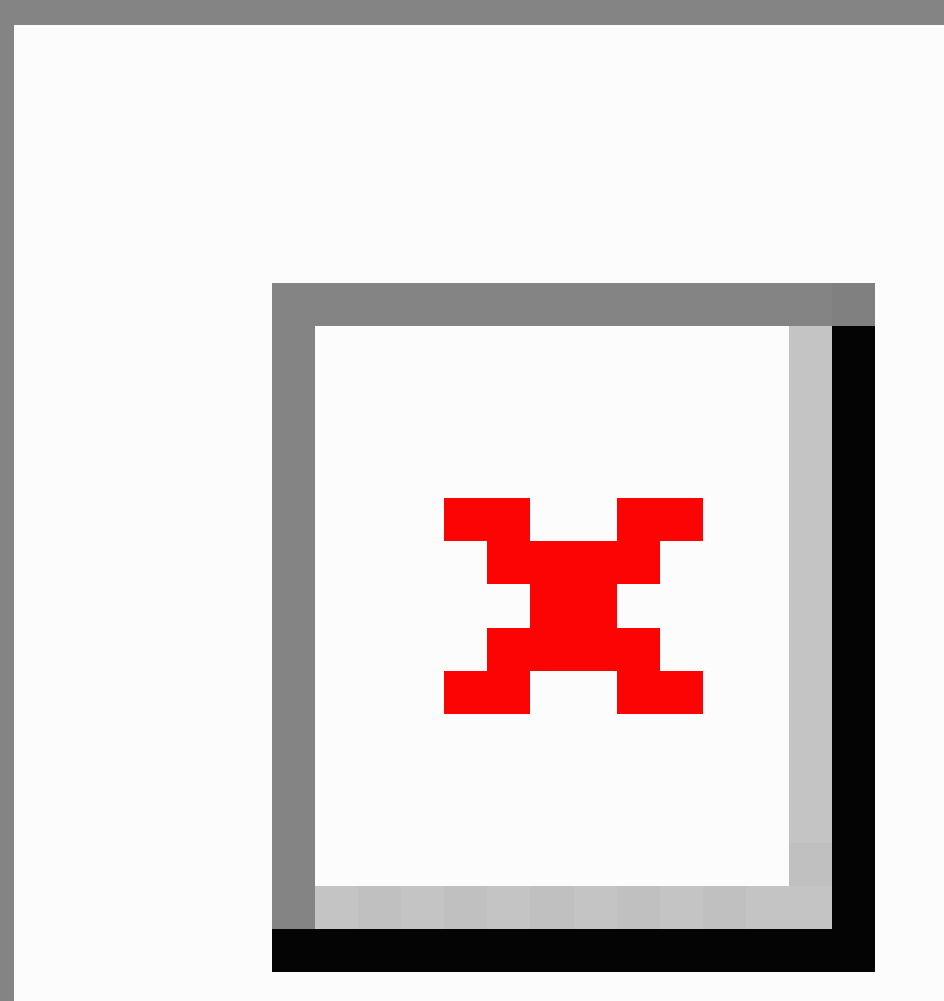
Figure 3. The data collection dashboard shows the data uploading status of all